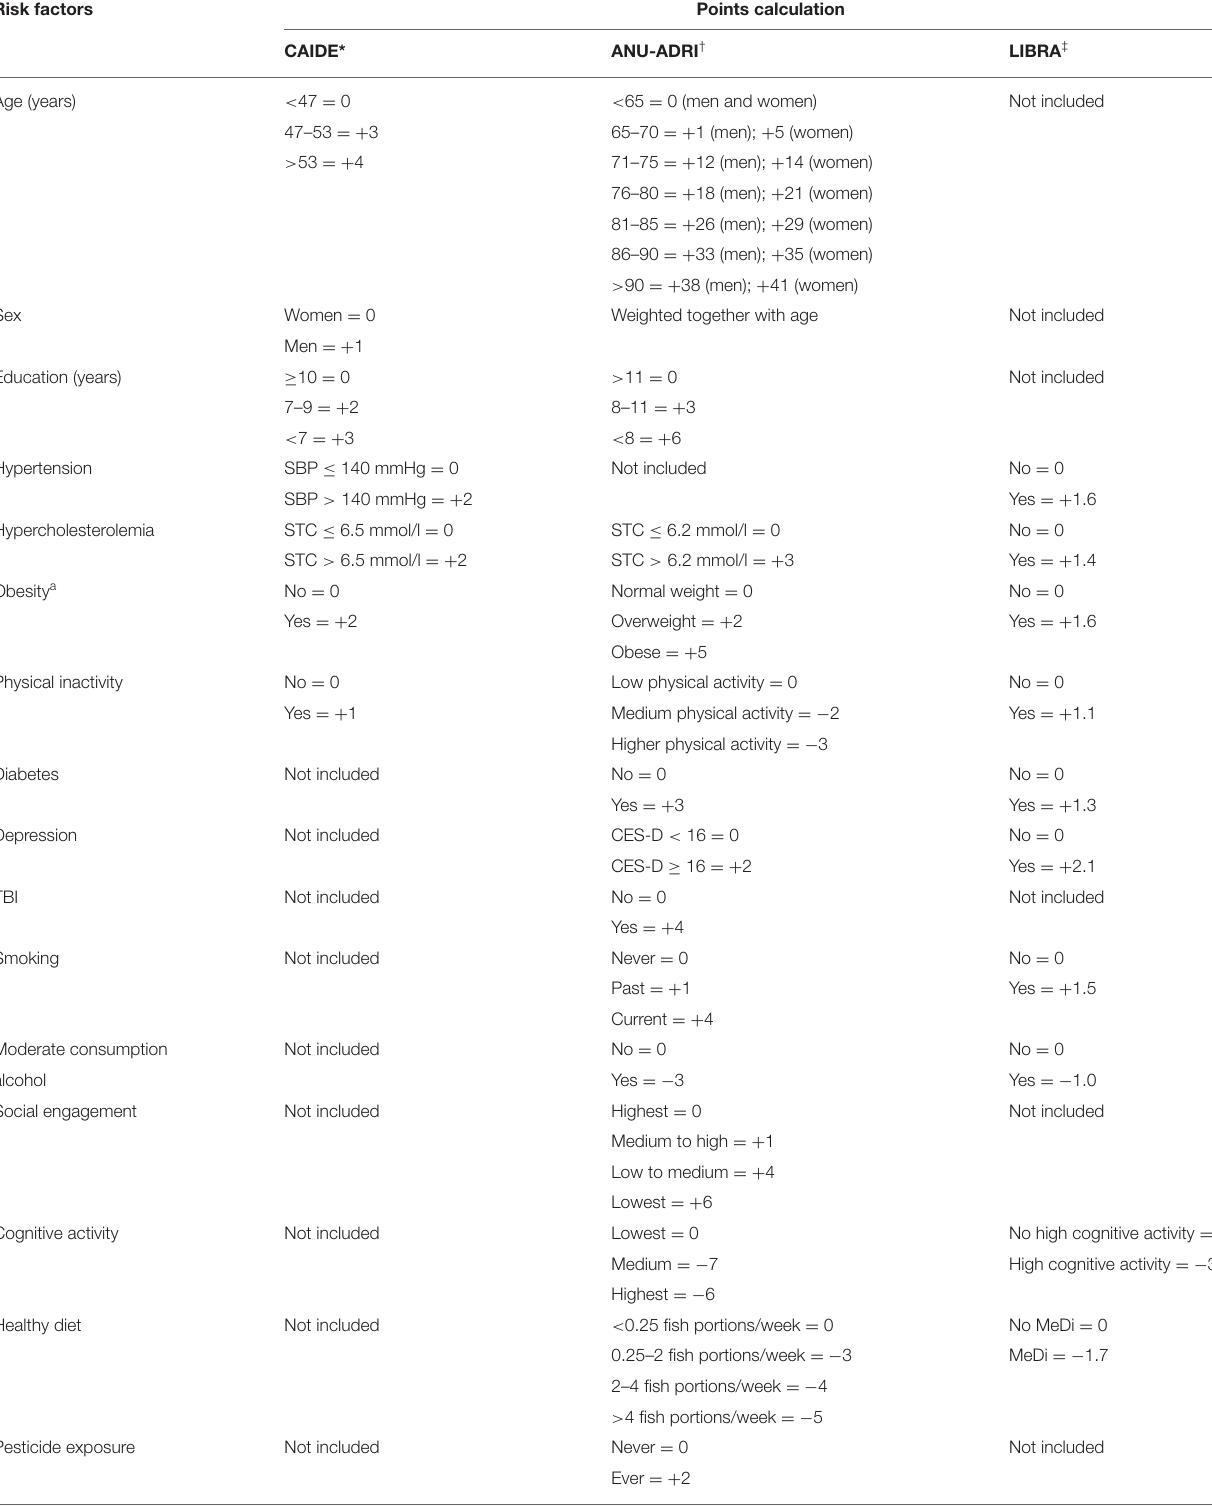
TABLE 1 | Algorithms of the CAIDE, ANU-ADRI, and LIBRA risk scores. Risk